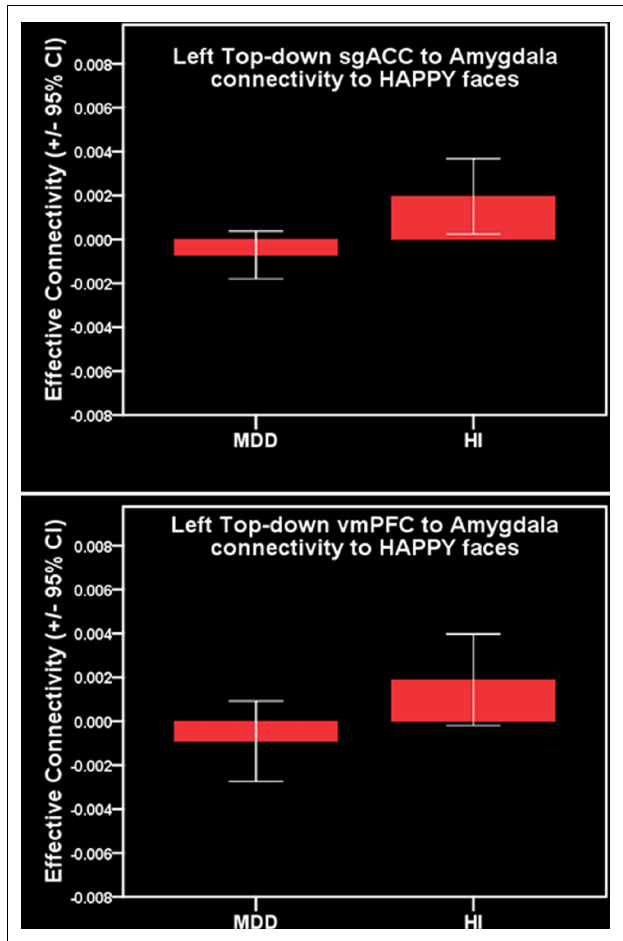
FIGURE 3 | Primary a priori analysis. Top: inverse left-sided vmPFC–amygdala connectivity to happy faces in females with MDD. Bottom: inverse left-sided sgACC–amygdala connectivity to happy faces in females with MDD.